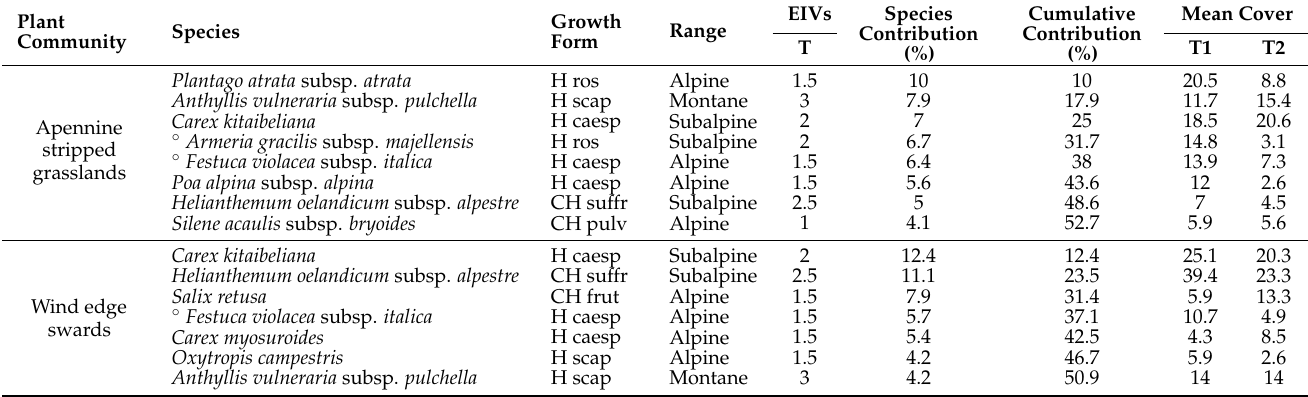
Table 2. Plant species that contribute up to the 50% to floristic changes over time (T1: 2003 and T2: 2021) assessed by the similarity percentage procedure (SIMPER) [79]. For each taxon, the growth form, the average altitudinal distribution of the species (Range), and species’ ecological indicator value for temperature (EIVs T) sensu Landolt [75], as well as the specific and cumulative contribution and the mean cover on T1 and T2, are also